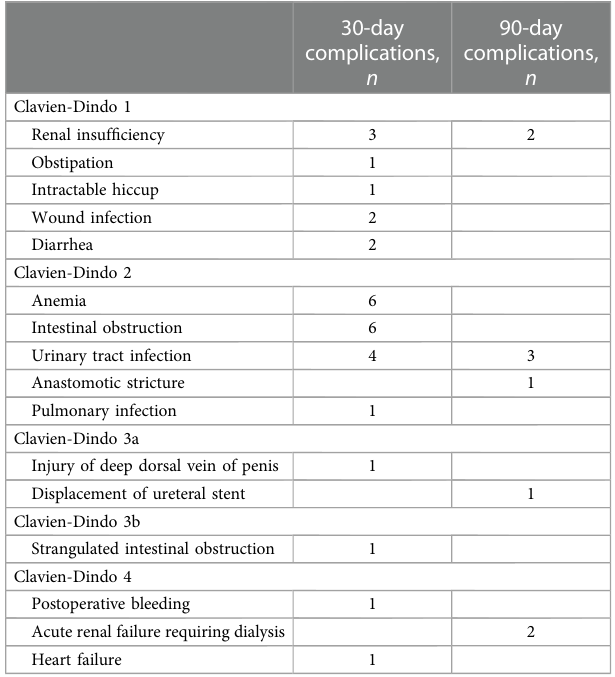
TABLE 4 Complications classi fi ed by clavien-dindo